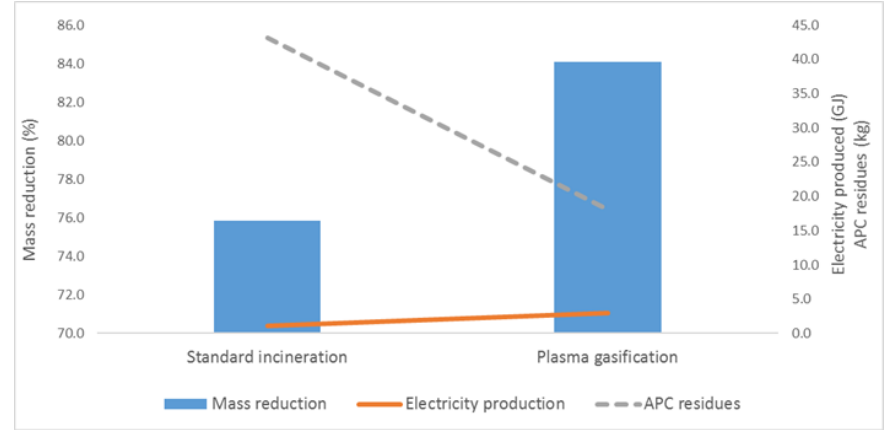
Figure 7. Efficiency performance comparison between incineration and two-stage plasma gasification of one ton of